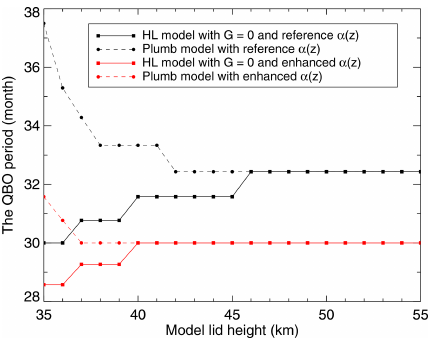
Figure 6. The relationship between the simulated QBO period with the height of the model lid. Black and red lines depict the results from using the reference radiative damping and the enhanced radia- tive damping, respectively, while solid and dashed lines delineate the results from the HL model with G = 0 and the Plumb model,